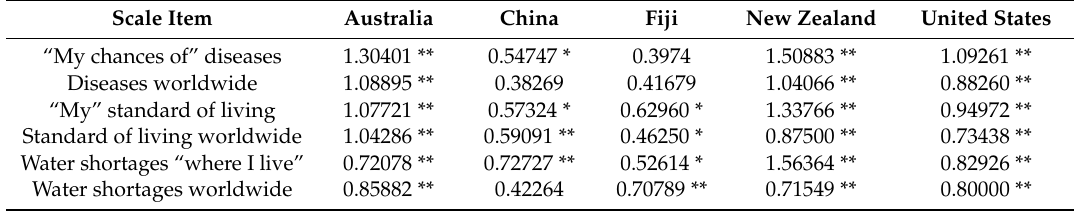
Table 6. Tukey HSD post-hoc analysis comparing Mexico to full sample